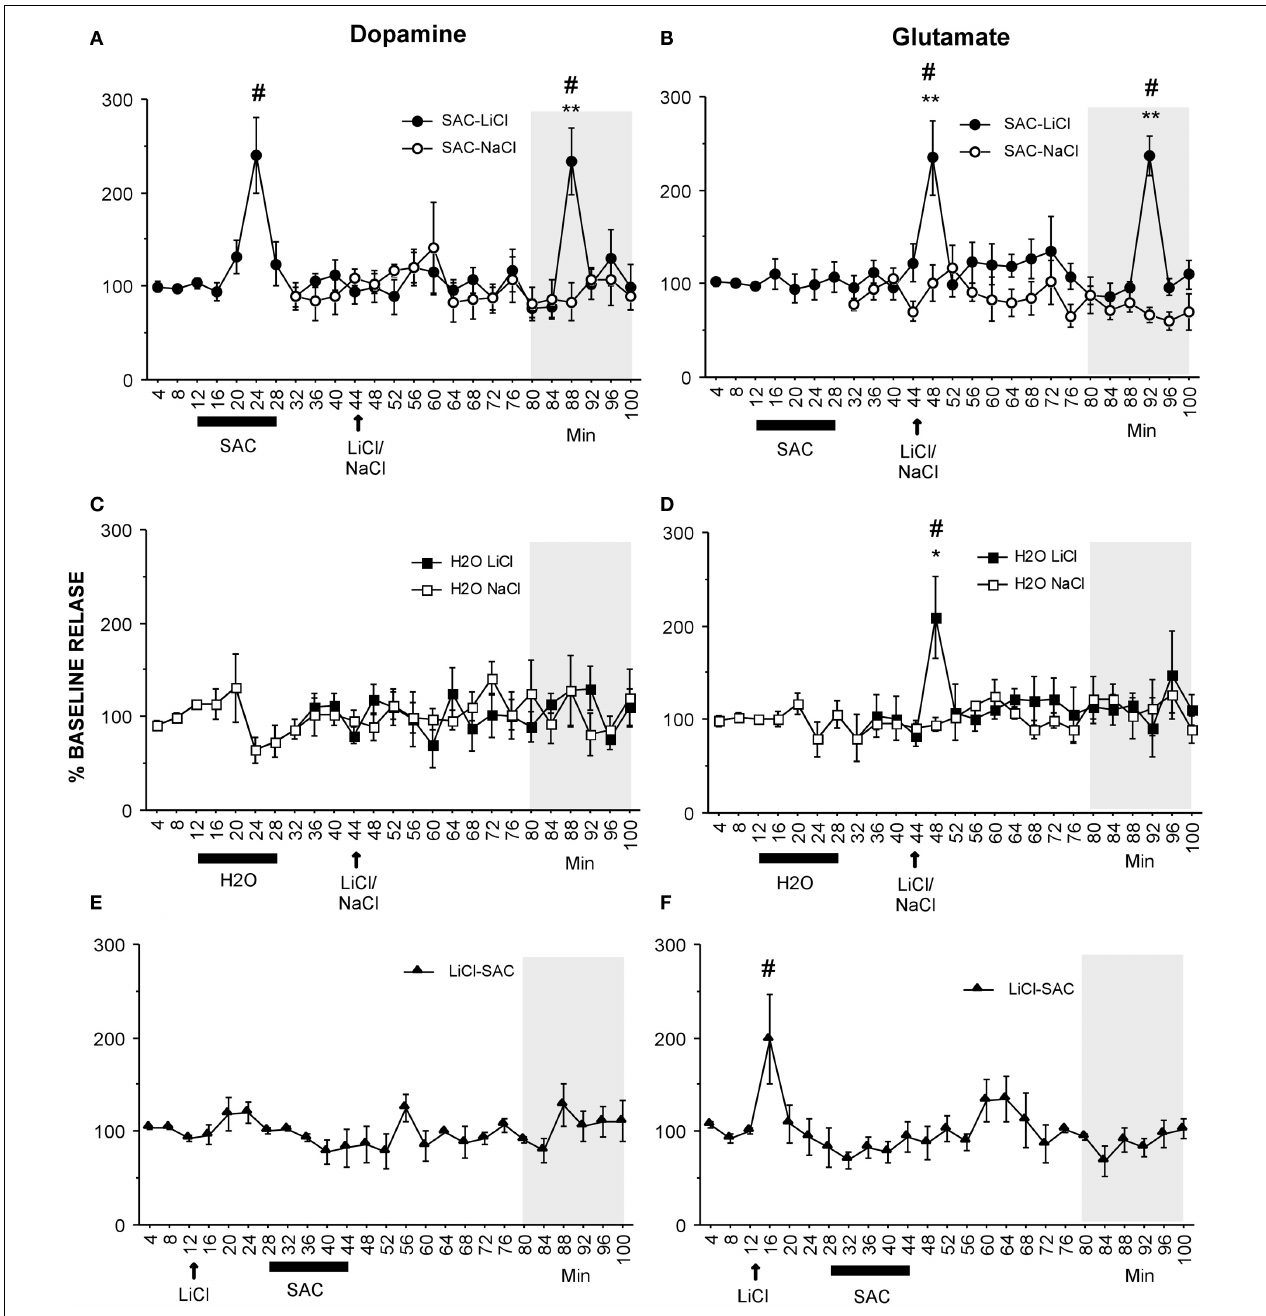
FIGURE 3 | Extracellular dopamine and glutamate levels in the IC increase concomitantly in the post-acquisition period of CTA training. (A) Dopamine monitoring: SAC-LiCl, conditioned group ( n = 10) received 0.1% saccharin solution followed by 0.4M LiCl i.p. injection (7.5mL/kg); SAC-NaCl, non-conditioned group ( n = 7) received 0.1% saccharin solution followed by 0.4M NaCl i.p. injection (7.5mL/kg); the CS elicited a dopamine increase in both groups but only the conditioned group showed a post-acquisition increase in the 88-min fraction. (B) Glutamate responses monitoring in conditioned and non-conditioned groups, the US elicited an increment in the SAC-LiCl group due to the LiCl injection but only the conditioned group showed a post-acquisition increase in the 92-min fraction. (C) Dopamine responses of control groups to stimuli: H 2 O–LiCl